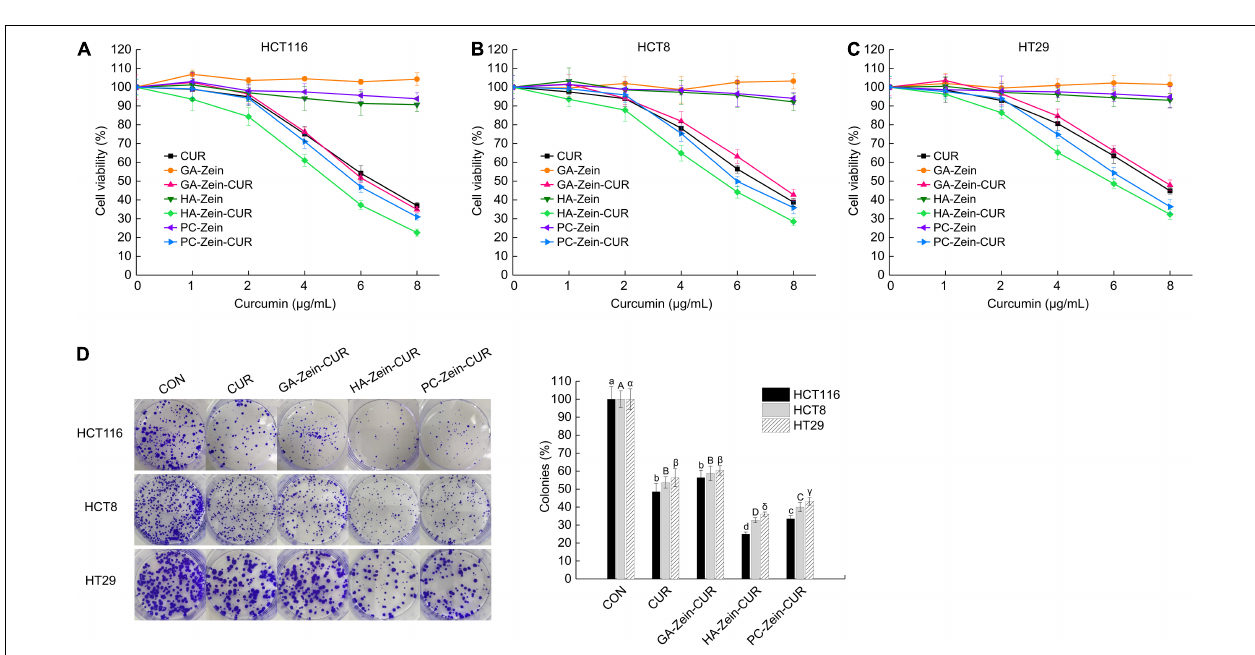
FIGURE 4 | Inhibitory effect of PS-Zein-CUR on CRC (HCT116, HCT8, and HT29) cell growth. Cells were treated with the indicated doses of CUR, PS-Zein, and PS-Zein-CUR for 48 h, respectively. (A–C) Cell viability measured by using a CCK-8 cell counting kit. (D) Left: images of colony formation assay; Right: quantitative analysis of colony formation expressed as percentage relative to vehicle control. Values are mean ± SD, n = 3. Bars marked with different letters indicate significant difference at P < 0.05.